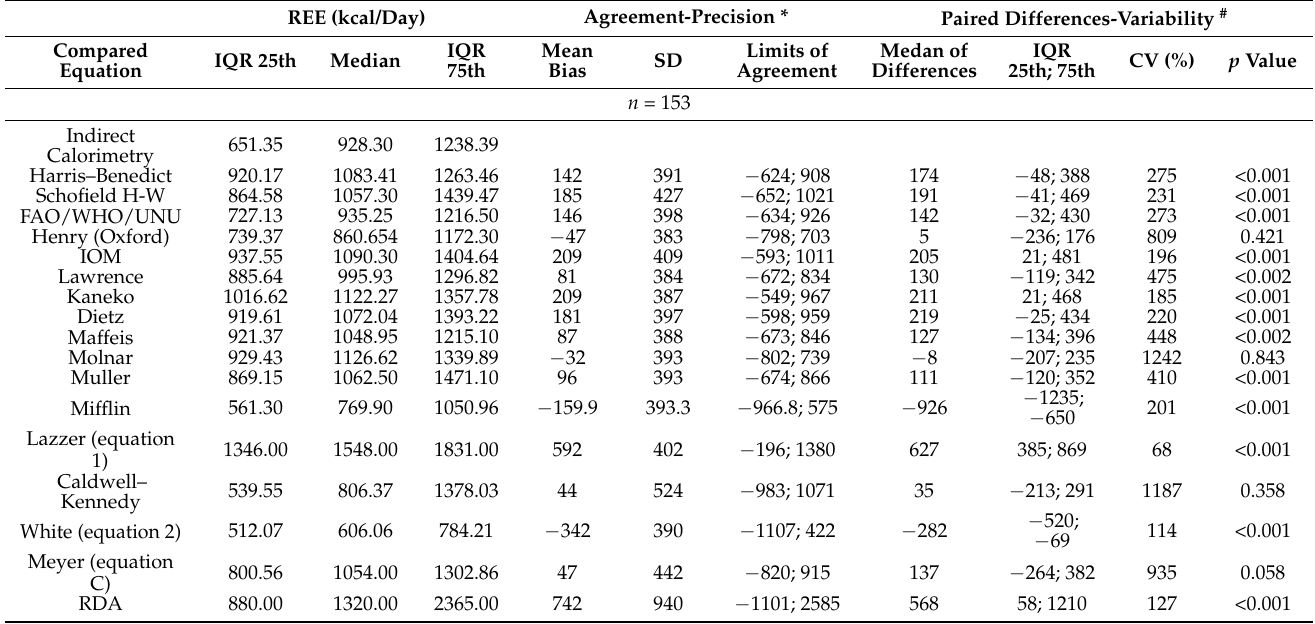
Table 2. Comparison analysis between resting energy expenditure measured by indirect calorimetry and calculations through predictive equations (kcal/day). Paired Differences-Variability